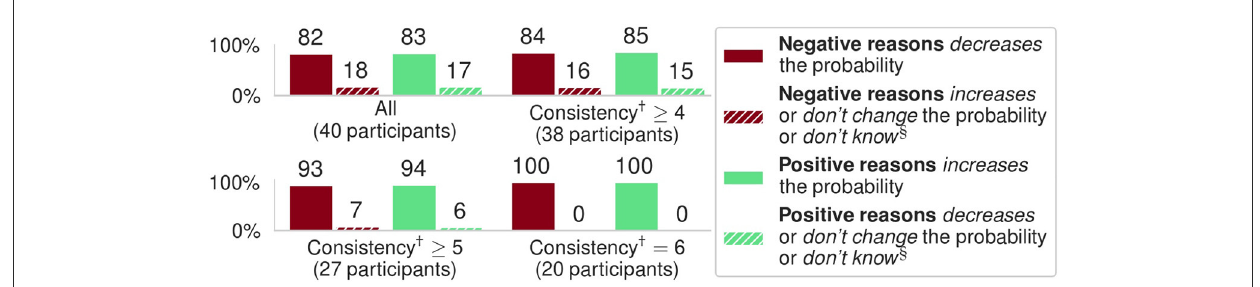
FIGURE3 Results of the experiments with 40 participants; all results are significant ( p << 0.001) against the null hypothesis of random answers. Here, “Negative/Positive reasons” refers to adding negative/positive contributions, resp., from features, as illustrated in Figure 2. ( † ) Consistency represents the number of questions (out of 6) users answered following the same pattern (also unexpected ones, e.g., that negative reasons increase probability). ( § ) We aggregated all results for unexpected answers in these bar